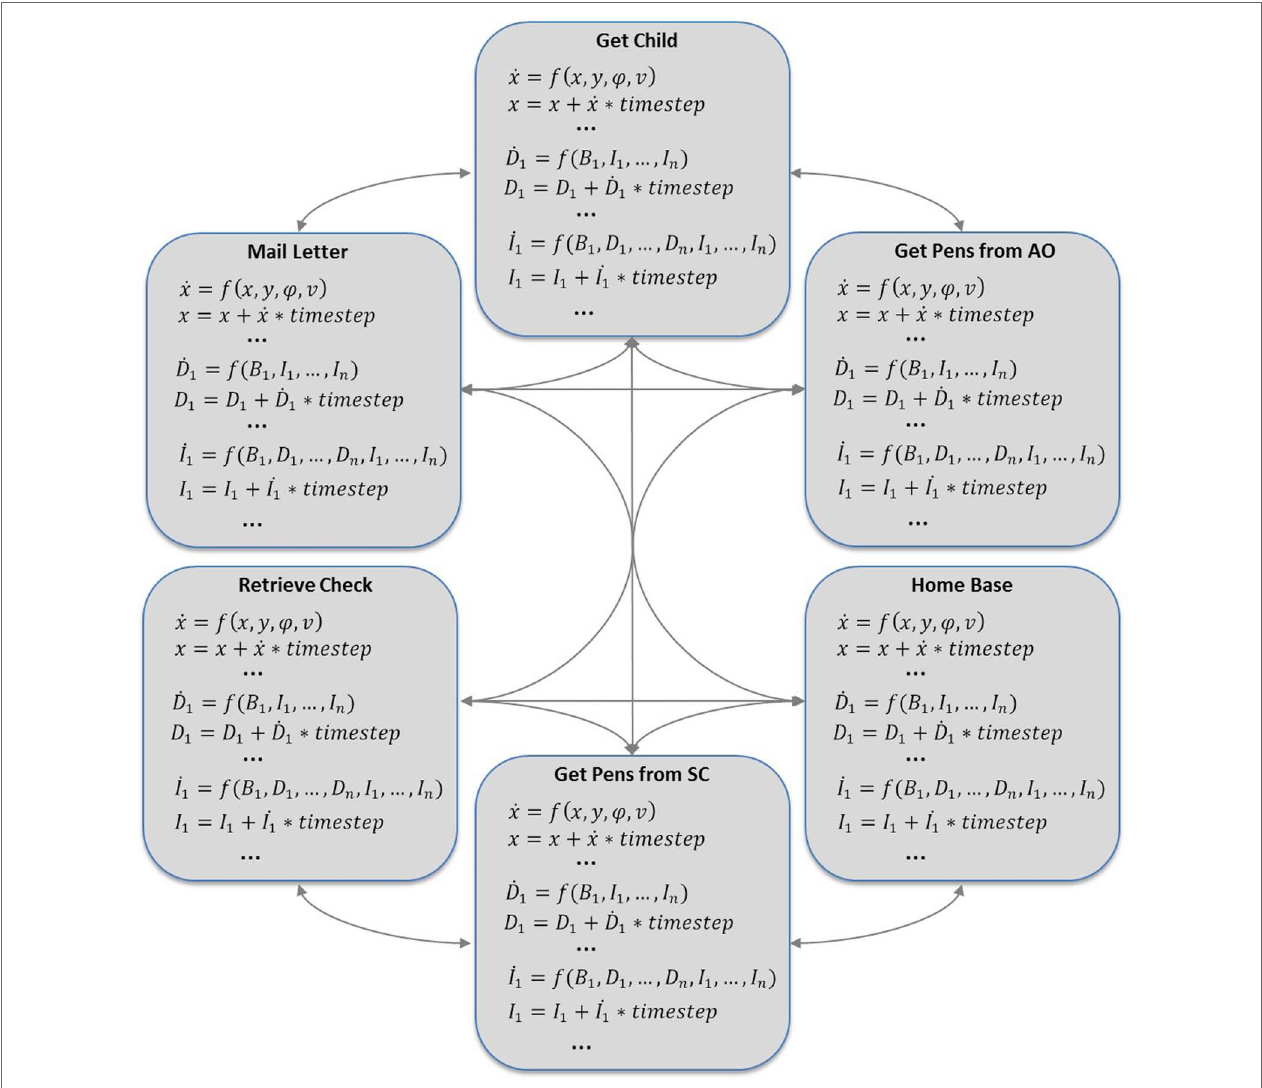
FIGURE 3 | Visualization of a full mode-level system model of a DI-HDCA service robot (see section 4) . Individual modes (see Figure 2 ) are in a state-transition model: at any moment, the agent is in one behavior mode; the change to a different behavior is modeled by a transition from one mode to another. It is not necessary in DI-HDCA models that every mode be connected to every other mode, but there is no restriction against a fully connected system such as the one shown here. Every cognitive and physical element in the DI-HDCA can be present in each mode, for use in that mode’s dynamical